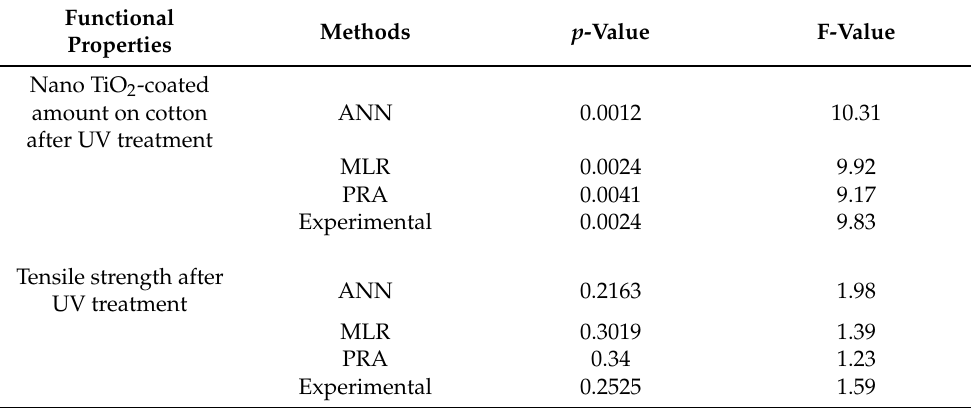
Table 4. Analysis report of experimental and predicted values of nano TiO 2 coated amount and tensile strength under ANN, MLR and PRA